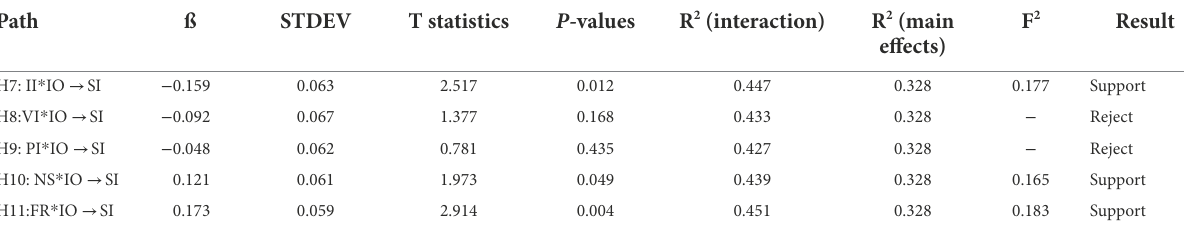
TABLE 6 Moderating effect analysis